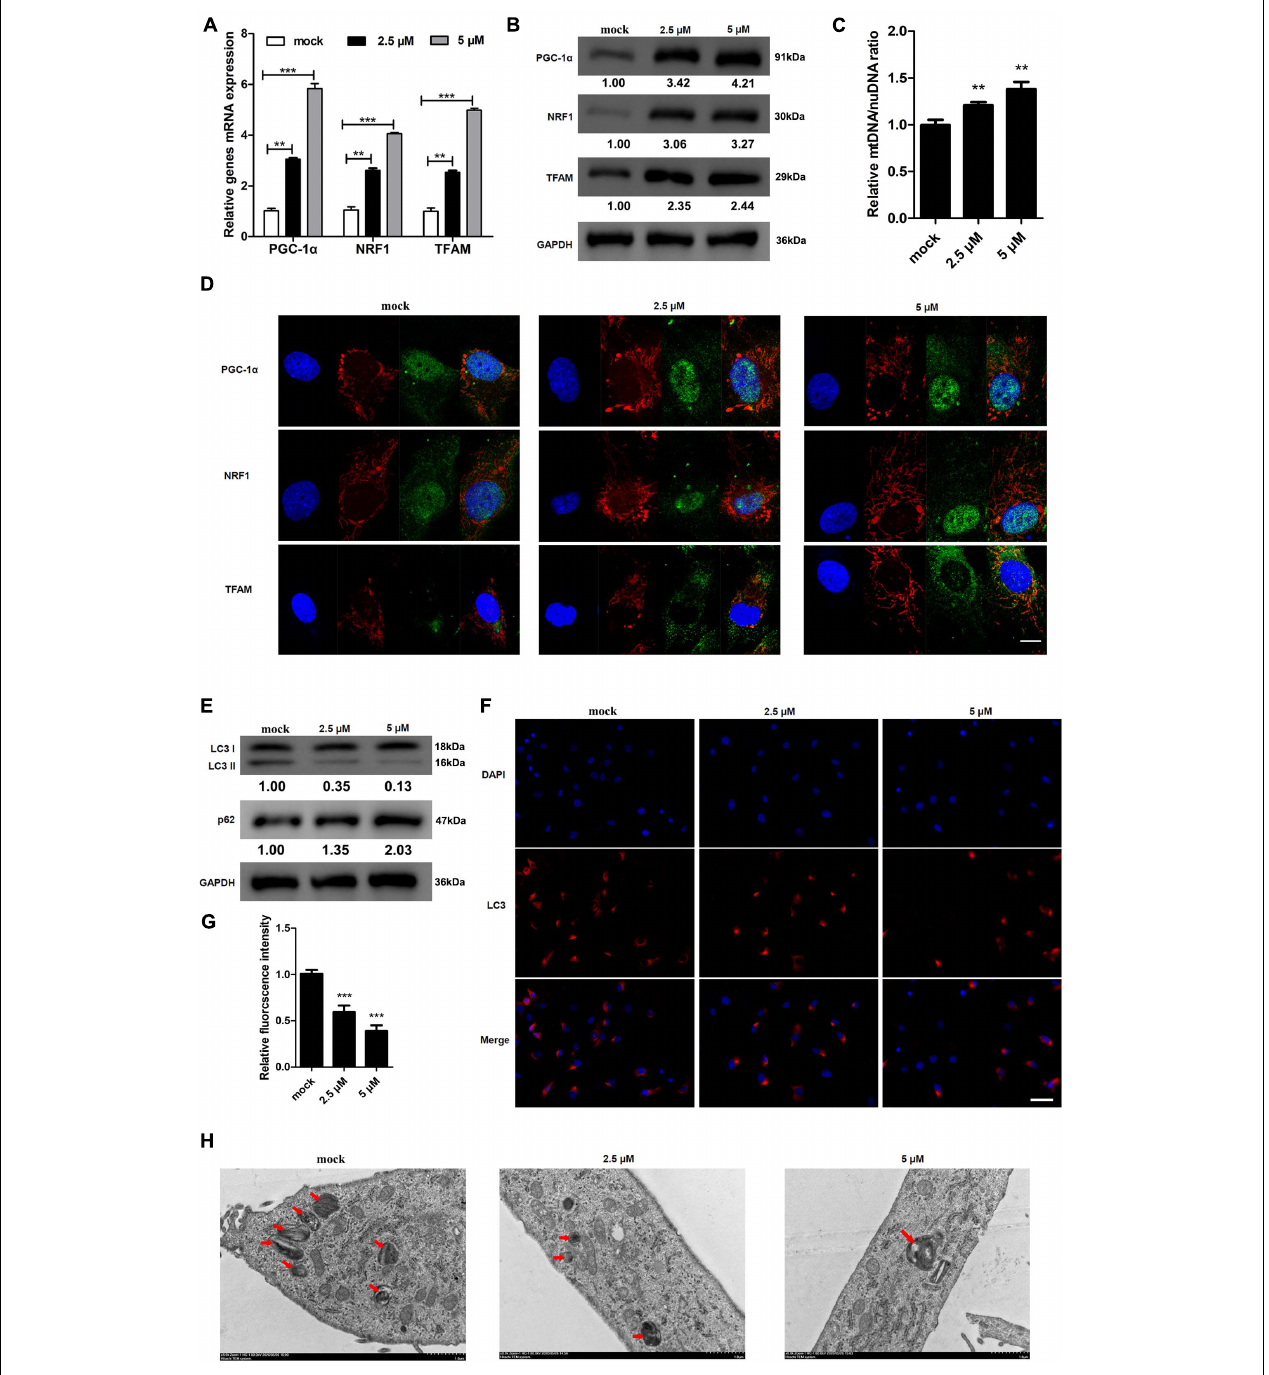
FIGURE 4 | REV-ERB agonist SR9009 promotes mitochondrial biosynthesis and inhibits autophagy in KGN cells. KGN cells were treated with different concentrations of SR9009 (2.5, 5 µ M) or mock-treated (mock) for 72 h. (A,B) Genes related to mitochondrial biogenesis levels in KGN cells treated with SR9009 were detected by qRT-PCR and western blotting. (C) Mitochondrial to nuclear DNA ratio. (D) Genes related to mitochondrial biogenesis protein levels in KGN cells treated with SR9009 were detected by immunofluorescence staining. Scale bars: 10 µ m. Blue fluorescence represents DAPI staining; Red fluorescence represents the location of mitochondria, which is stained by Mitotracker; Green fluorescence represents targeted protein expression; Yellow indicates merged images. (E) The expression of LC3 and p62 in KGN cells treated with SR9009 were detected by western blotting. (F) The expression of LC3 in KGN cells were detected by immunofluorescence. Scale bars: 50 µ m. Blue fluorescence represents DAPI staining; Red fluorescence represents LC3 expression. (G) Relative quantification of LC3 fluorescence intensity. (H) Morphological observation of autophagy in KGN cells treated with SR9009 under transmission electron microscopy. Scale bars: 1.0 µ m. Data are presented as means ± SEM. ** P < 0.01, *** P < 0.001 vs. mock.